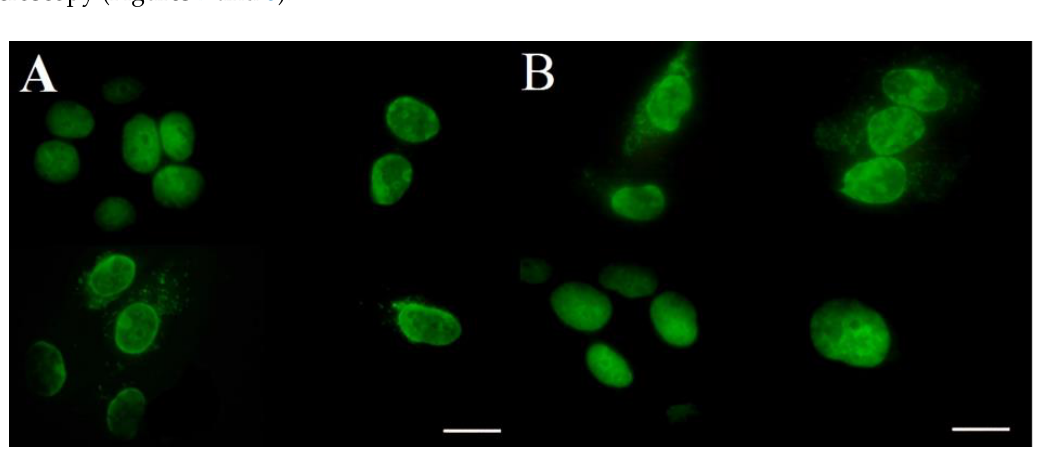
Figure 7. Nucleus of HaCaT cells stained by DAPI. A: DMSO control, B: treated with 17.0 µM of compound 10 .